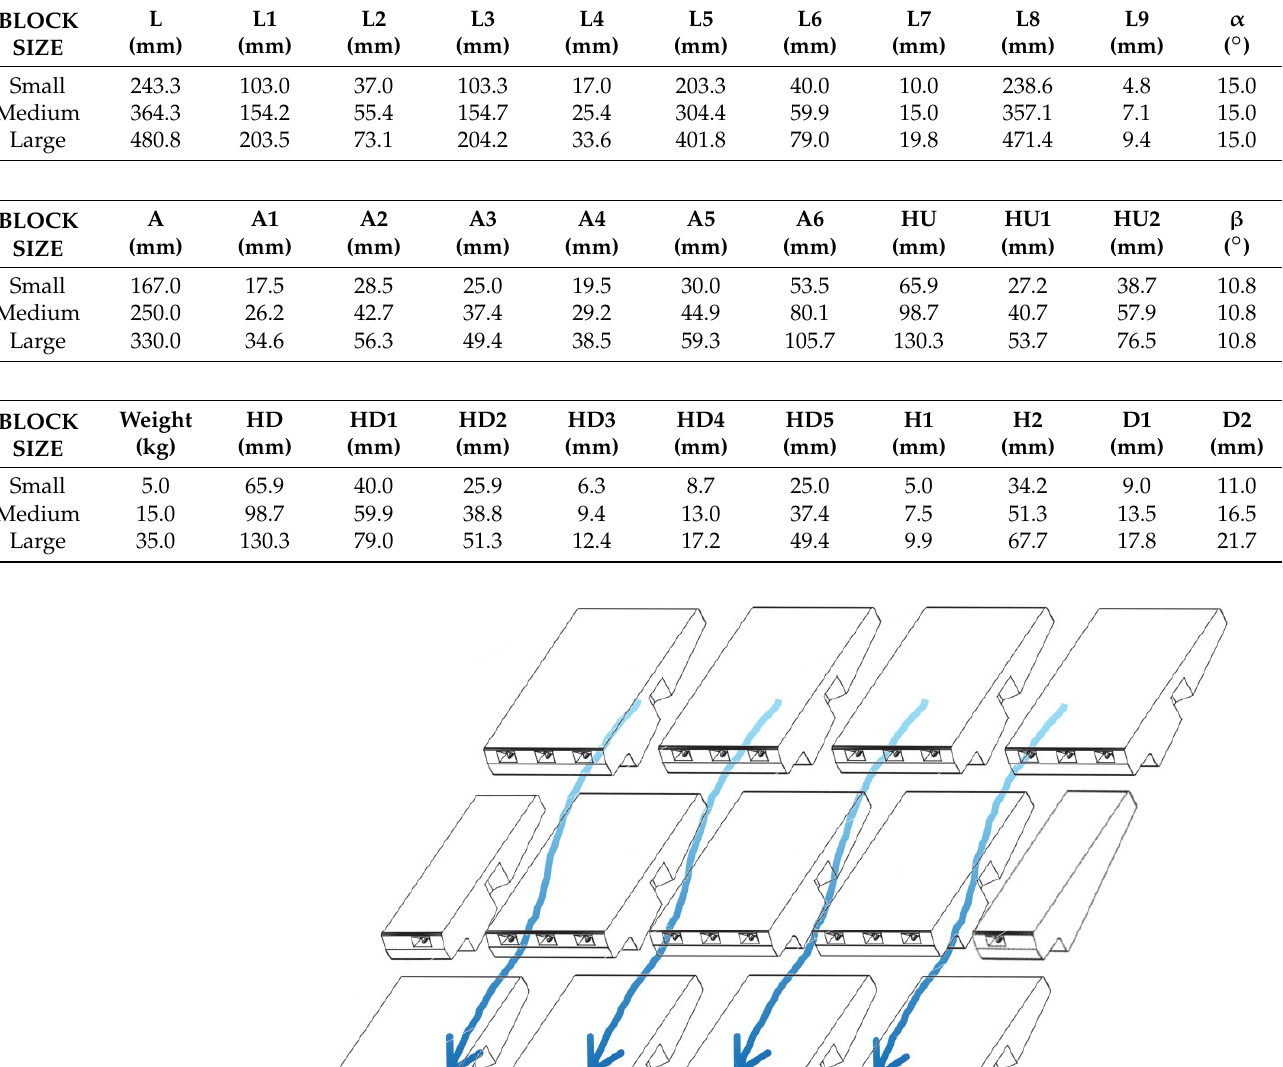
Table 1. Dimensions and weights of the three sizes of the tested blocks.